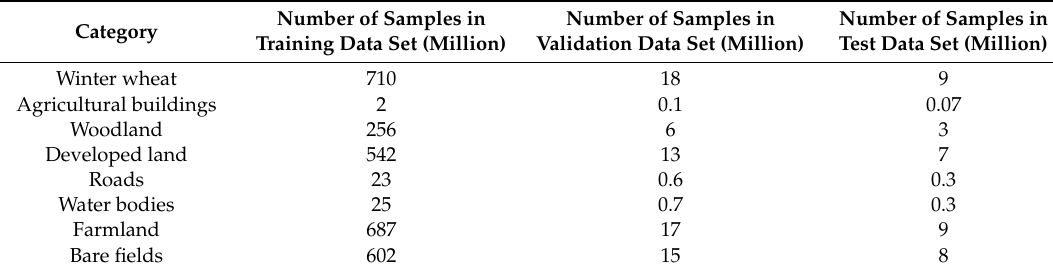
Table 3. Number of samples used in the